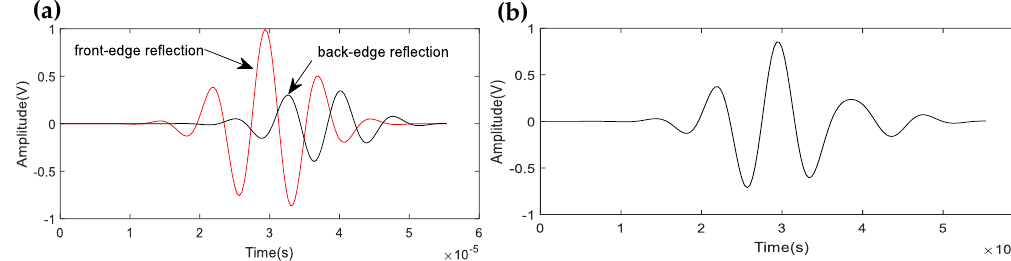
Figure 7. Reflection wave from the front- and back-edge of a reflector and their overlapping wave: ( a ) reflection wave from a reflector; ( b ) overlapping wave.